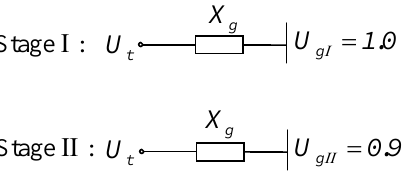
Figure 5. Equivalent AC circuits of GCC connected to the AC grid under different operating stages.